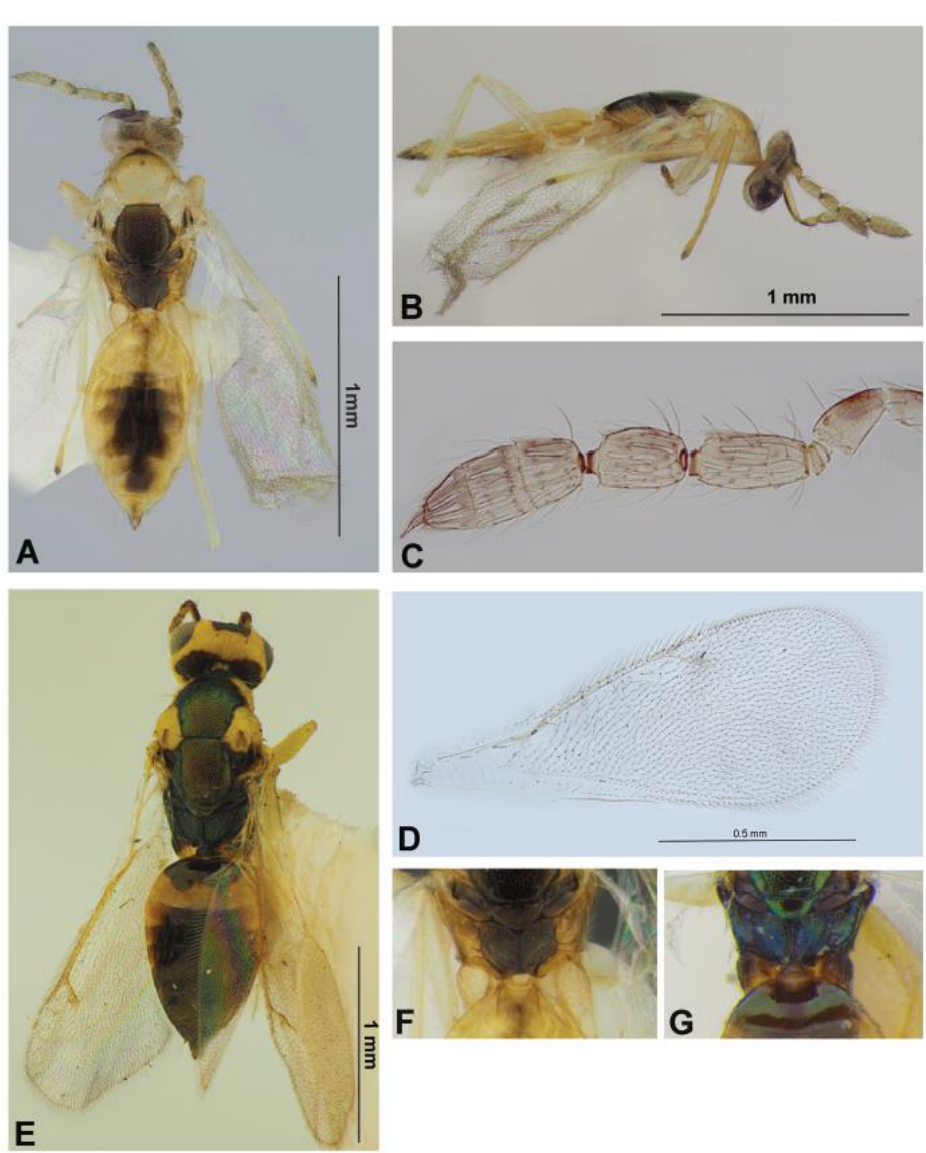
Figure 4. Eulophinae (females): Cirrospilus ussuriensis sp. nov. ( A – D , F ) and C. diallus Walker, 1838 ( E , G ). Habitus, dorsal view ( A , E ) and lateral view ( B ), flagellum ( C ), fore wing ( D ), dorsellum and propodeum ( F , G ).